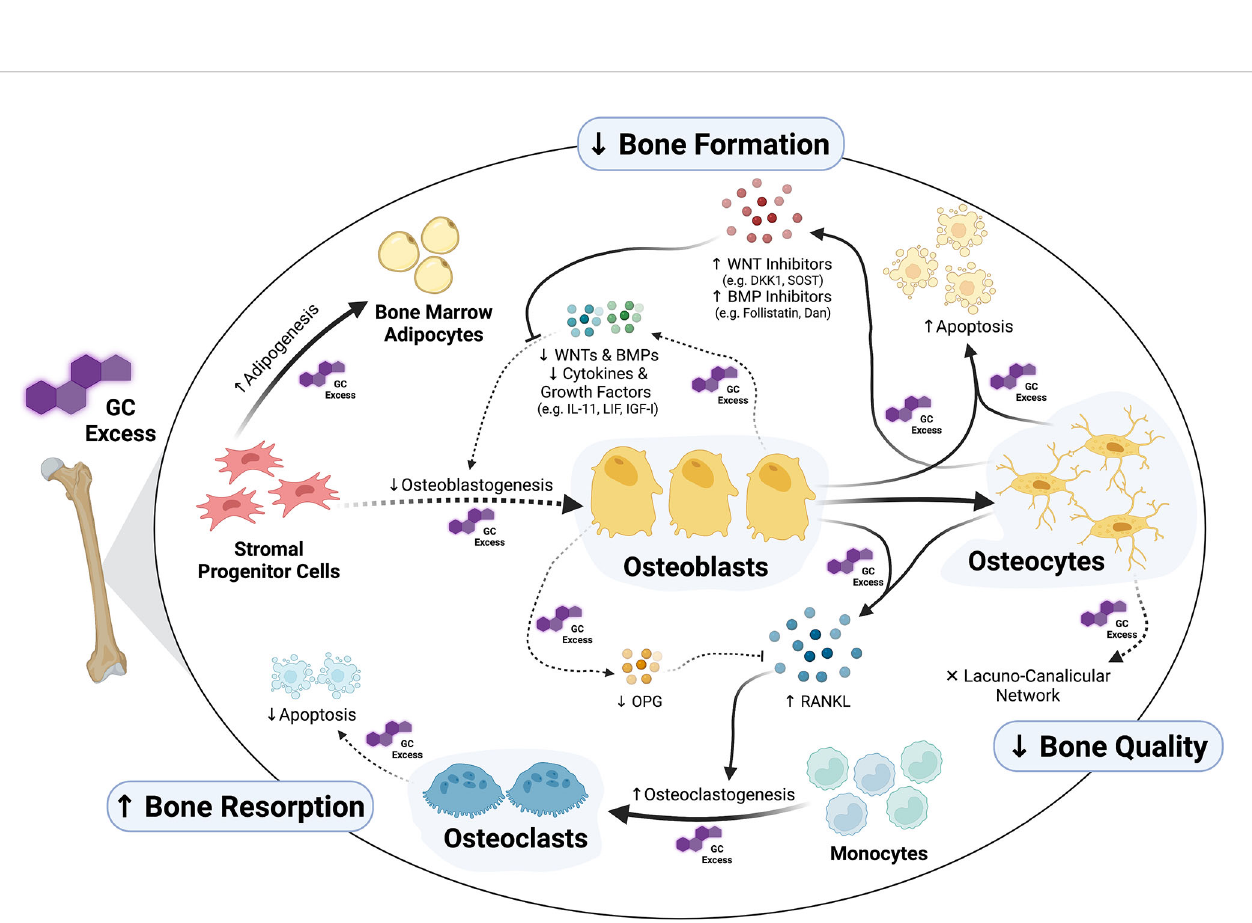
FIGURE 1 | Osteoblasts and osteocytes as main targets of glucocorticoid (GC) excess in the skeleton. Exposure to supra-physiological levels of GCs affects many aspects of osteoblast formation and function. Whereas GCs inhibit osteogenic commitment of stromal progenitor cells by diversion into adipogenesis, they inhibit proliferation and differentiation of pre-osteoblasts through direct as well as autocrine/paracrine effects. Together with suppression of osteoblast function, all these GC-induced alterations in osteoblasts suppress bone formation. Additionally, GCs induce apoptosis of both osteoblasts and osteocytes and cause disruptions in osteocytic lacuna-canalicular network affecting bone quality. Osteoclast-mediated bone resorption is affected by GCs as well, especially through the regulation of the RANKL/OPG system via osteoblasts and osteocytes. The fi gure was created with